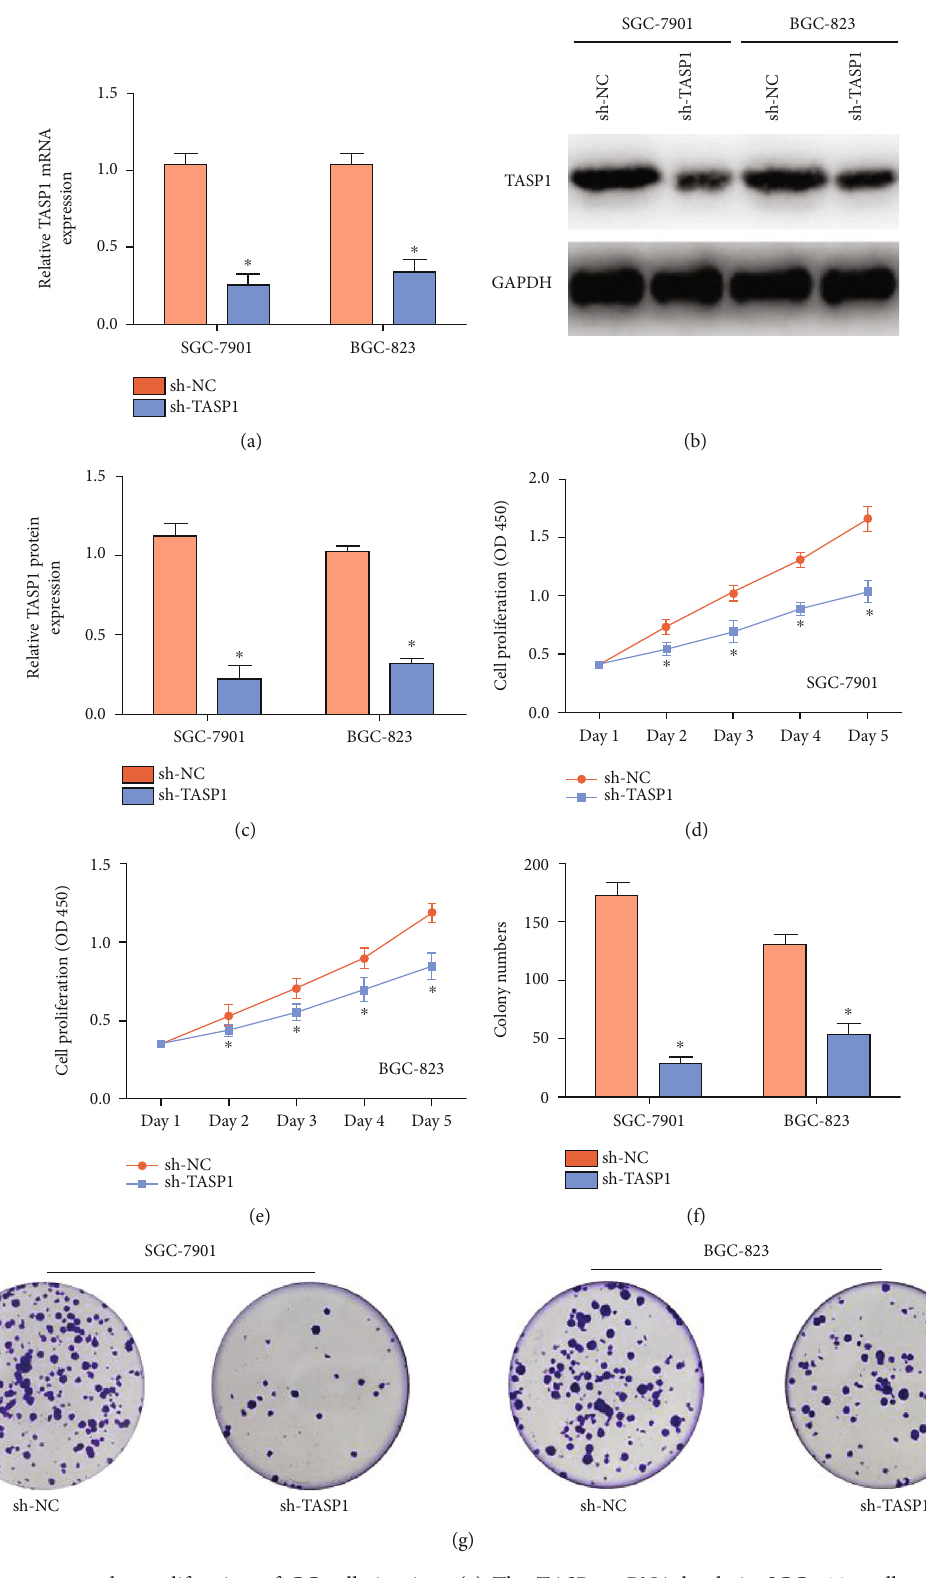
Figure 2: TASP1 promotes the proliferation of GC cells in vitro. (a) The TASP1 mRNA levels in SGC-7901 cells and BGC-823 cells transfected with sh-TASP1 ð ∗ p < 0 : 05 Þ . (b, c) The levels of the TASP1 protein in SGC-7901 cells and BGC-823 cells transfected with sh- TASP1 ð ∗ p < 0 : 05 Þ . (d, e) The proliferation ability of SGC-7901 cells and BGC-823 cells that were transfected with sh-TASP1 ð ∗ p < 0 : 05 Þ . (f, g) Analysis of the number of GC colonies and their statistical signi fi cance ð ∗ p < 0 : 05 Þ